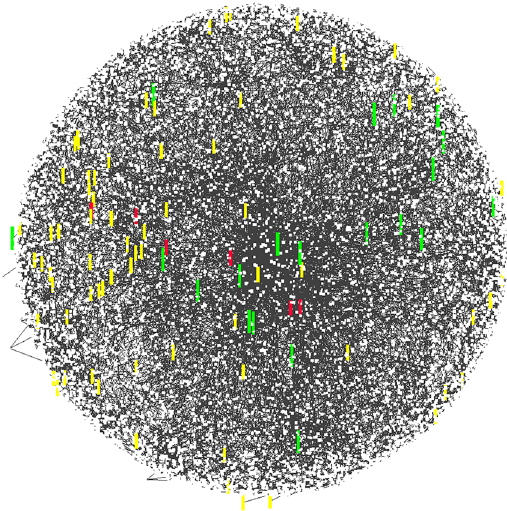
Figure 6. The metabolic network of baicalin (Yellow indicates the baicalin-related targets, green indicates the verified biomarkers and red indicates the fever-related